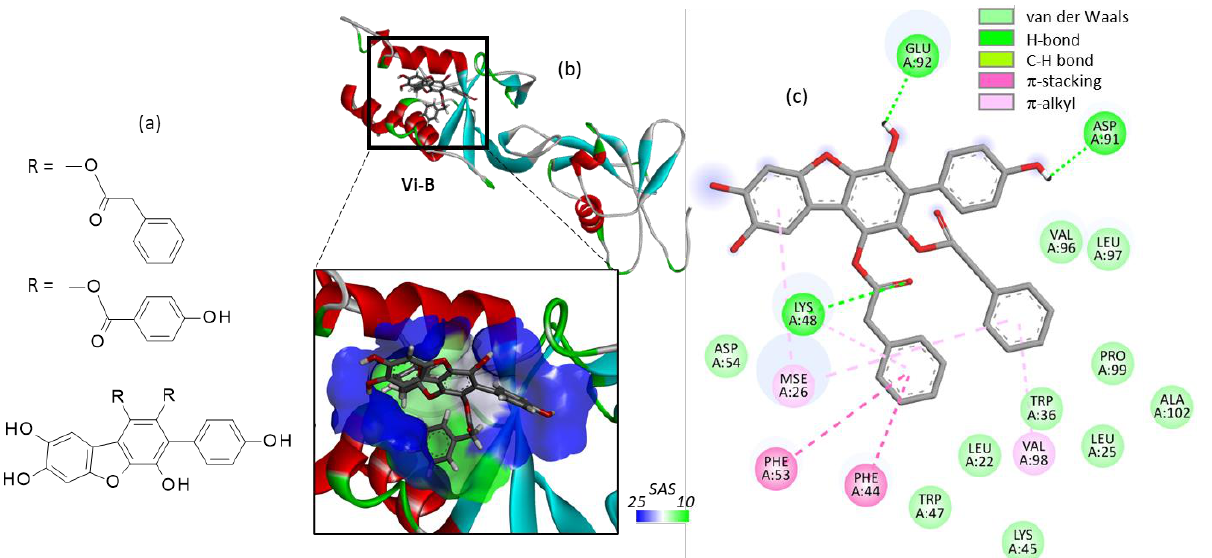
Figure 3. Structures of vialinins B and C. Molecular model of vialinin B (Vi-B) bound to USP4. ( a ) Ribbon model of Vi-B bound to the V98 site. ( b ) A close-up view of the compound in the binding site, with the solvent accessible surface (SAS) colored (color code indicated). ( c ) Binding map contact, with the indicated color code. Table 1. Calculated potential energy of interaction ( E, kcal/mol) for the interaction of terphenyl compounds with USP4 (PDB: 3JYU).